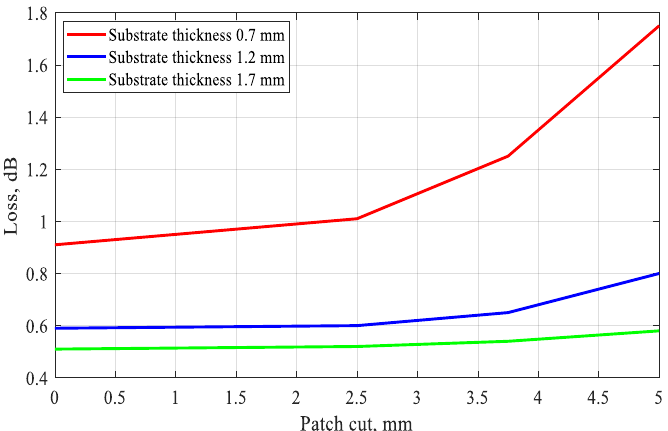
Figure 2. The dependence of the unit-cell insertion loss on cutout lateral size for different substrate